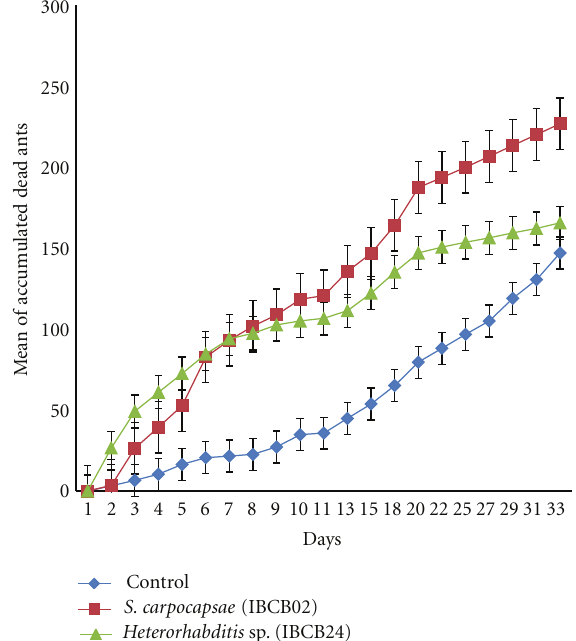
Figure 1: Mean of cumulative mortality of Monomorium floricola workers treated with entomopathogenic nematodes from five experimental